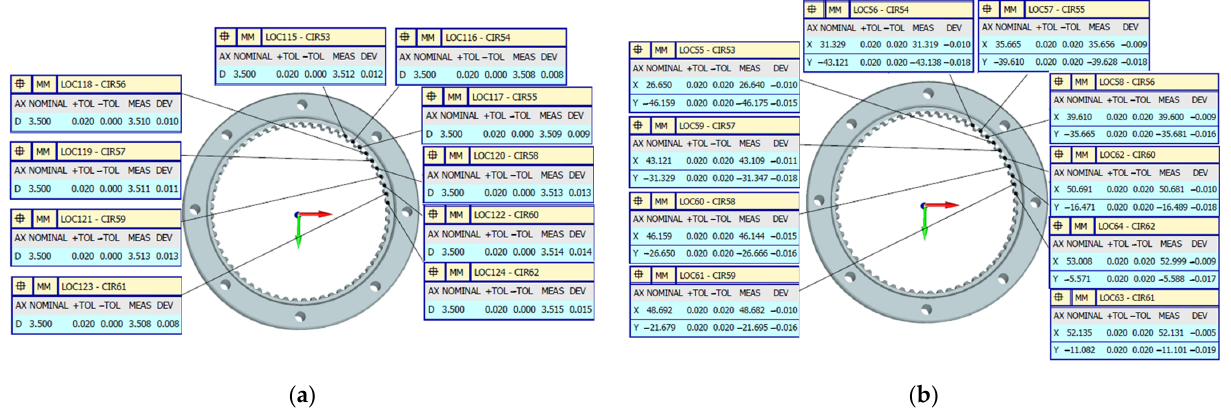
Figure 2. The manufacturing errors of the ring gear: ( a ) the pin-groove radial error; ( b ) the pin-groove position error.